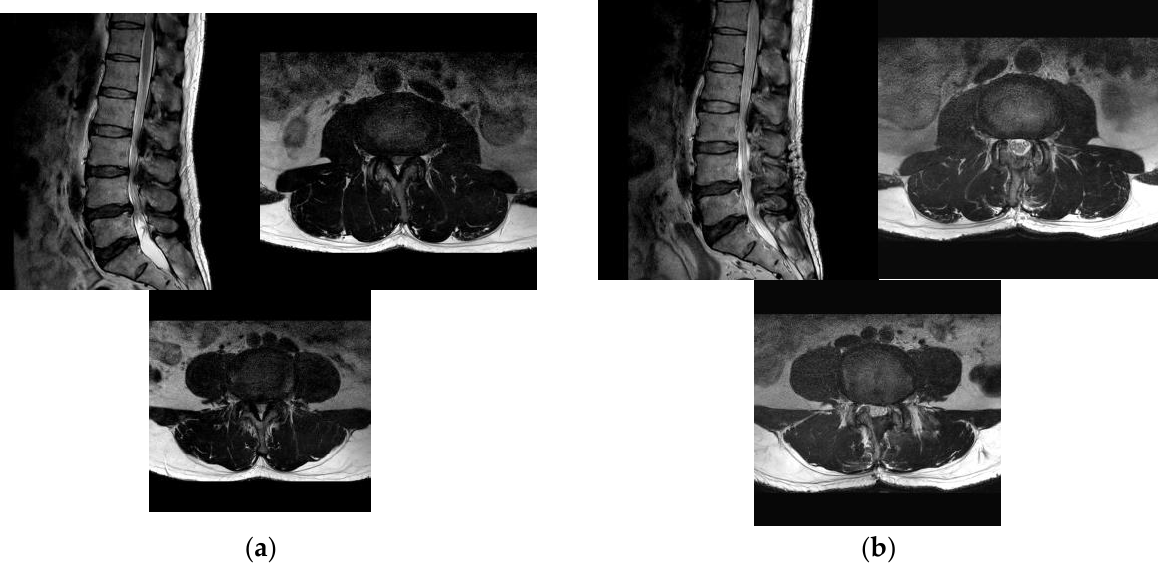
Figure 2. Pre-operative ( a ) and post-operative ( b ) MR images of a 72-year-old female patient with L3 – 4 – 5 spinal stenosis who underwent microscopic ULBD surgery.